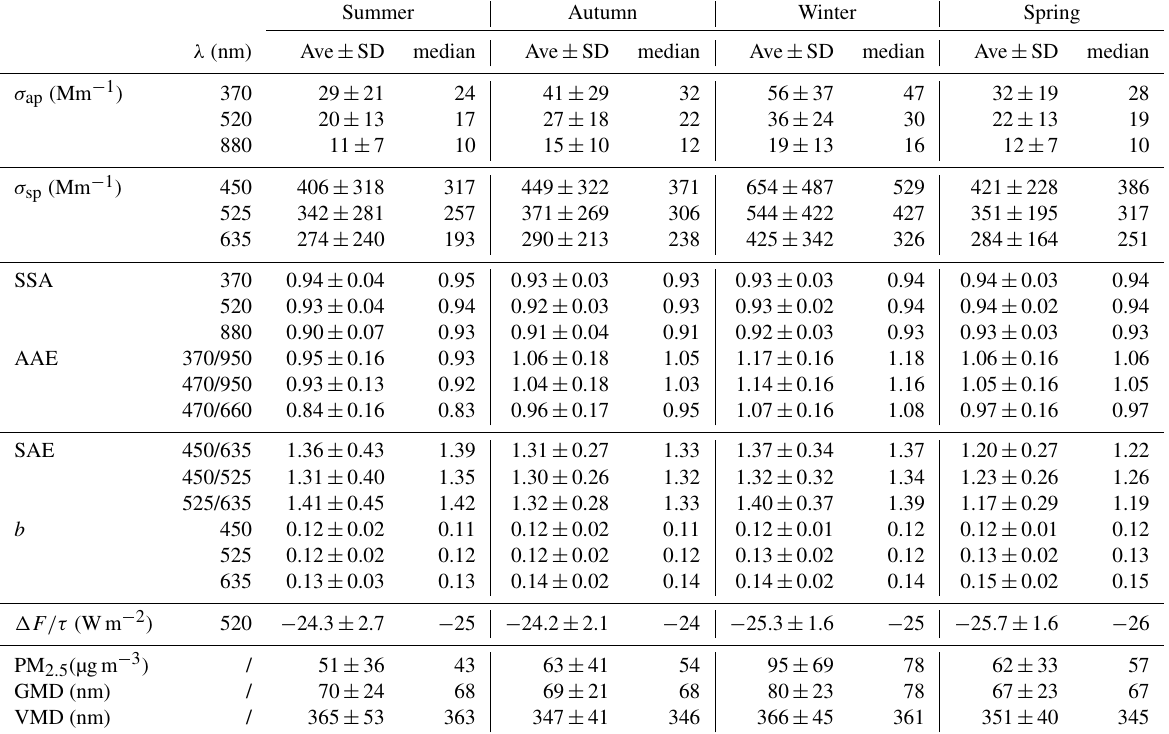
Table 3. Statistical summary of hourly-averaged aerosol optics data and associated parameters in summer (June–August), autumn (September–November), winter (December–February), and spring (March–May). For explanations, see the caption of Table